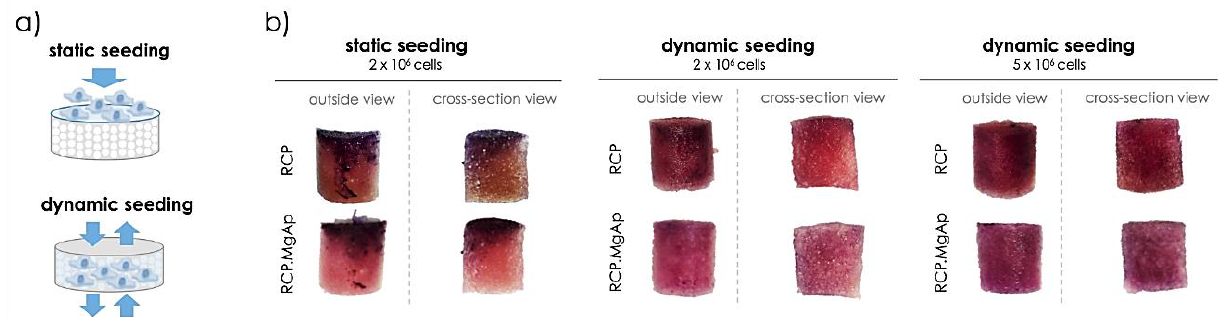
Figure 4. Cell seeding optimization. ( a ) Schematic design of the cell seeding approaches: static seeding in a well-plate and dynamic seeding in a perfusion bioreactor. ( b ) Representative images of MTT staining obtained after 24 h of hMSC culture on mineralized (RCP.MgAp) and non-mineralized (RCP) scaffolds. Full scaffolds were cross-sectioned in half in order to assess the cell distribution also in the center of the scaffold.